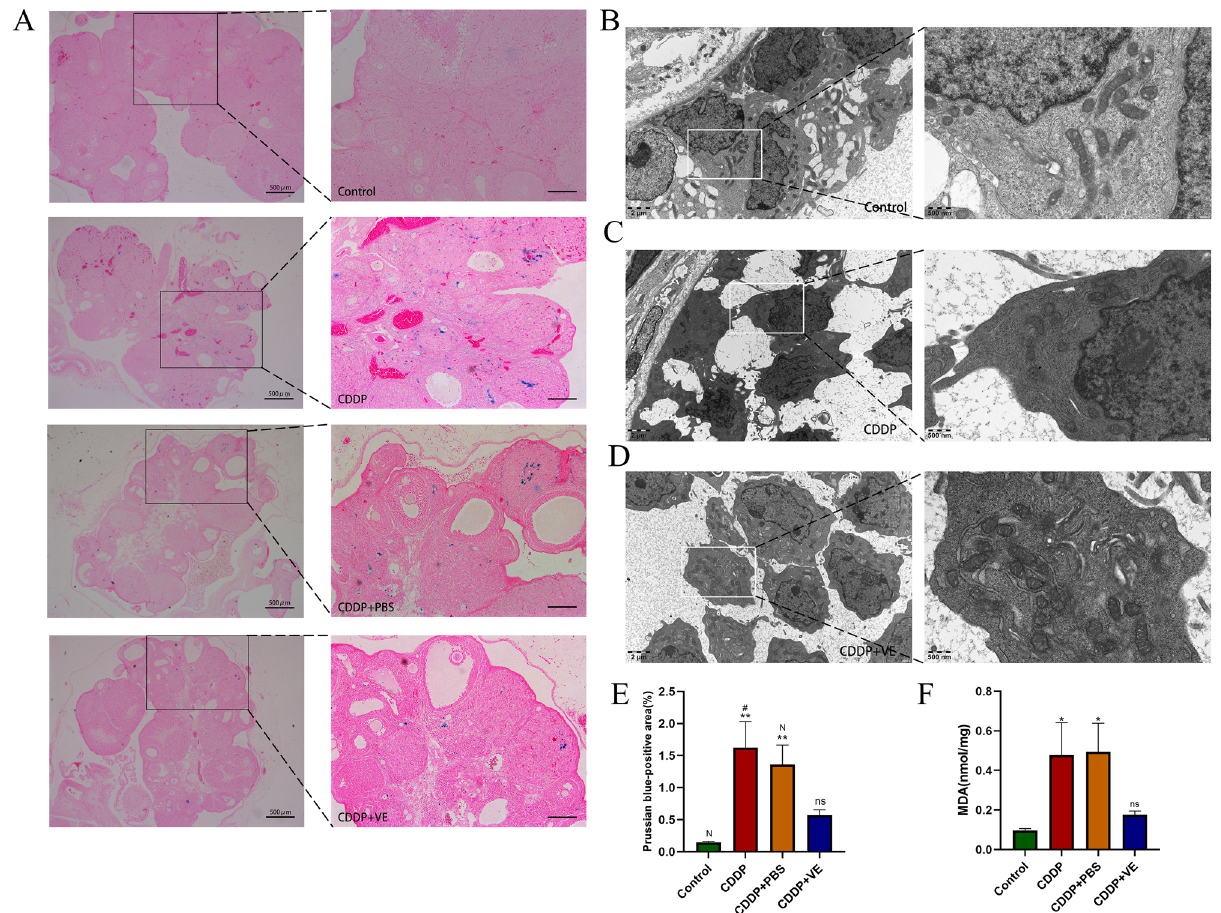
Figure 4. Effects of CDDP and VE on ferroptosis in ovarian tissue. ( A , E ) Perls staining of ovarian tissues in each group, and Fe 3+ blue positive areas were calculated using image J computing software. Scale bar 200 μm. ( B , C , D ) Transmission electron microscopy was used to observe the mitochondrial ultrastructure in GCs in the ovary tissues of each group. ( F ) MDA expression levels in ovarian tissues of each group. Data are expressed as the means ± SEM. n = 20, ns, * versus control, * P < 0.05, ** P < 0.01, *** P < 0.001 and **** P < 0.0001, ns indicates no statistical significance. N, # versus CDDP + VE, # P < 0.05, ## P < 0.01, ### P < 0.001 and #### P < 0.0001, N indicates no statistical